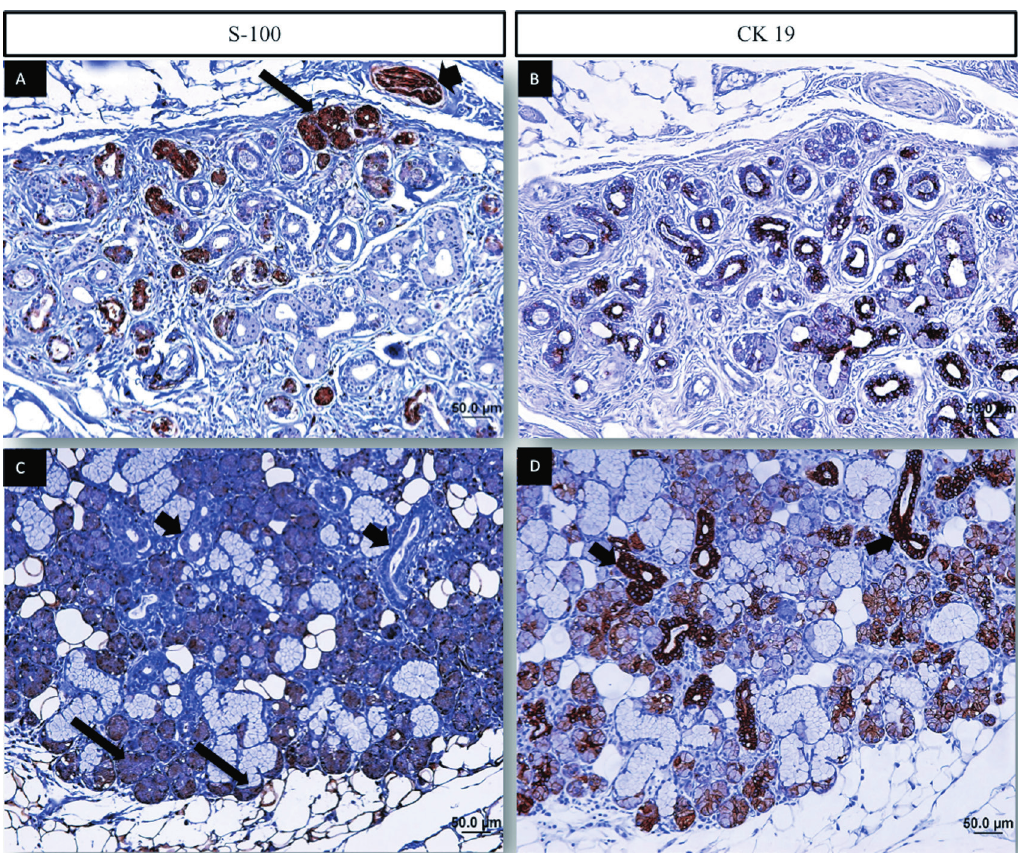
Figure 3- A: Duct-like structures (DLS) with weak or absent S-100 expression. A strong expression of S100 seen in the nerve cells (short arrow) can be regarded as the positive control. Serous cells with strong expression (arrow) (Group II); B: Strong expression of CK 19 in some cells in the DLS. Serous cells with weak expression (Group II); C: Positive S-100 expression in serous acinar cells (arrows) and negative in ducts and DLS (short arrows) (Group I); D: Strong CK 19 expression in ducts and DLS (arrows) and weak or moderate expression in serous acinar cells (Group J Appl Oral Sci.